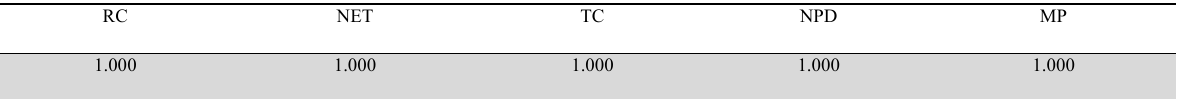
Internal Consistency Analysis (Reliability) Composite reliability coefficients, Cronbach's alpha coefficients, and Average variances extracted RC NET